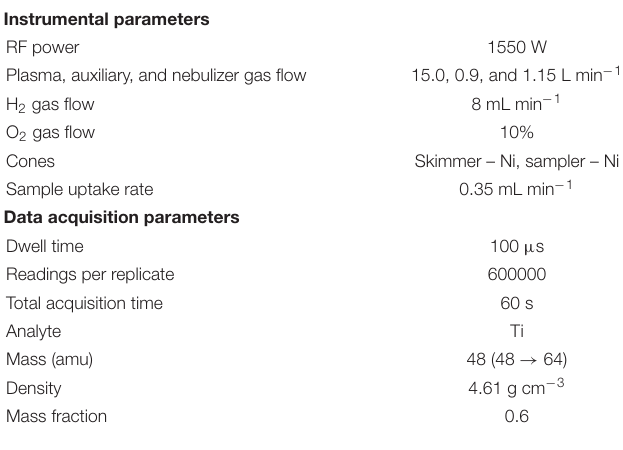
TABLE 1 | Default instrumental and data acquisition parameters for